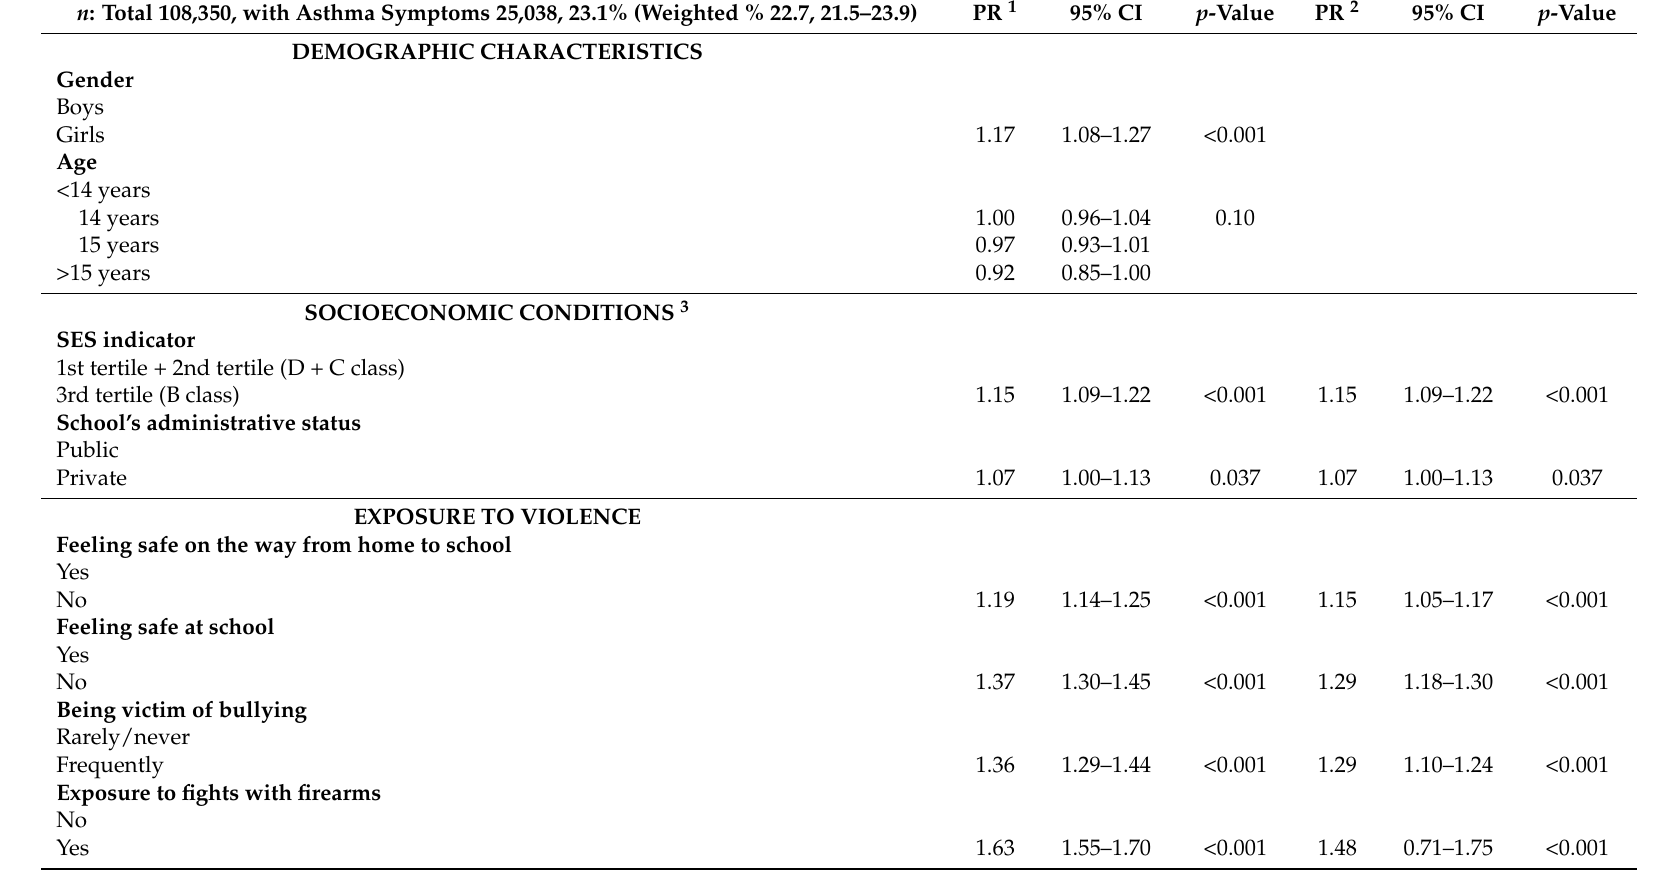
Table 2. Asthma Symptoms in Brazilian Adolescents Characteristics Studied, Intra-Block and Final Analysis. PeNSE survey